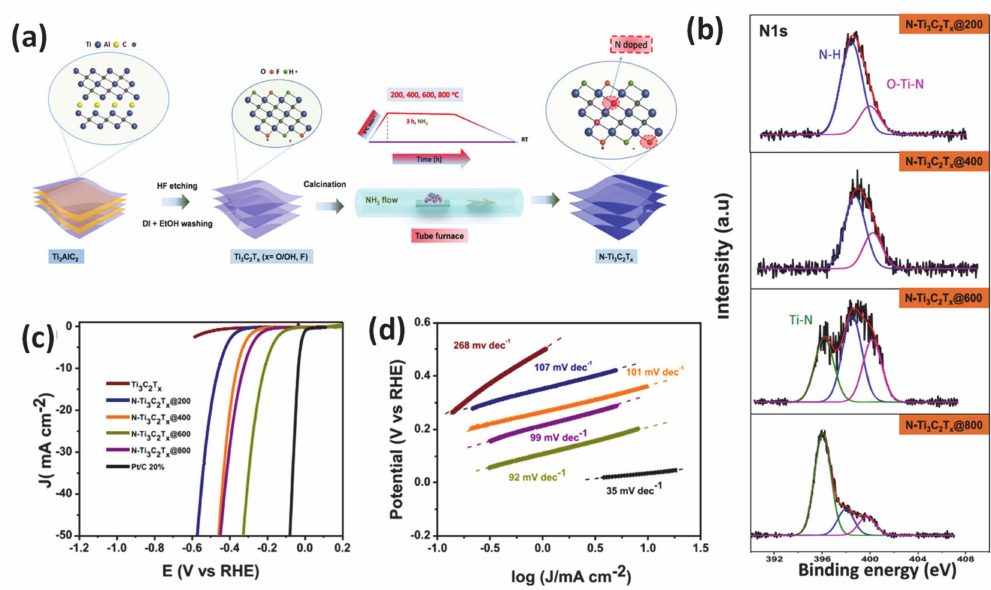
Figure 6. ( a ) Illustration of synthesis of nitrogen-doped MXene (N-Ti 3 C 2 T x ) from the Ti 3 AlC 2 MAX Phase, ( b ) core-level X-ray photoelectron spectroscopy (XPS) of the N 1s of N-doped MXene samples annealed at various temperatures, ( c ) HER polarization curves of various obtained-electrocatalysts, ( d ) corresponding Tafel plots. Reproduced with permission [137]. Copyright 2019, American Chemical